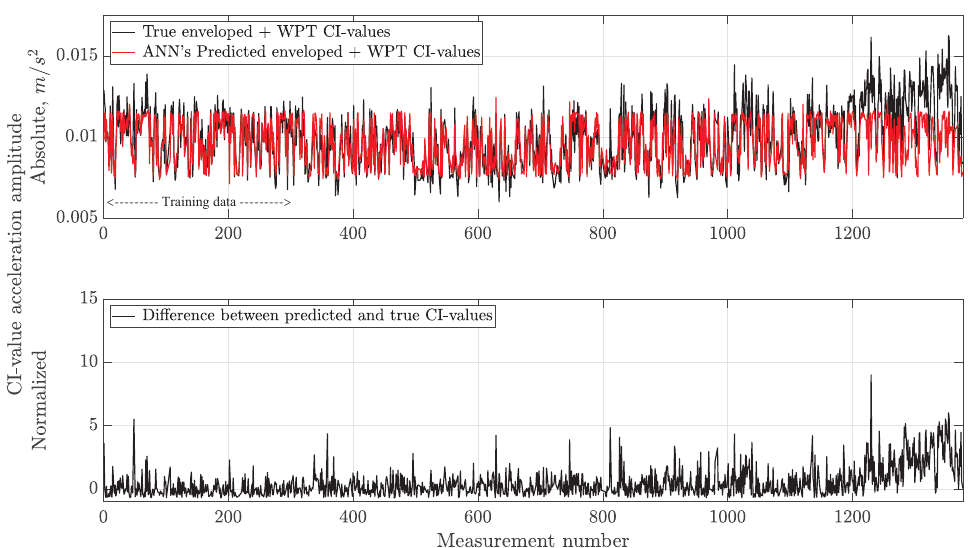
Figure 8. Failure case 2, planet bearing failure, enveloped WPT CI-values. Comparison of ANN’s predicted CI-values in red and true CI-values in blue at the top graph and normalized difference between them at the bottom graph.